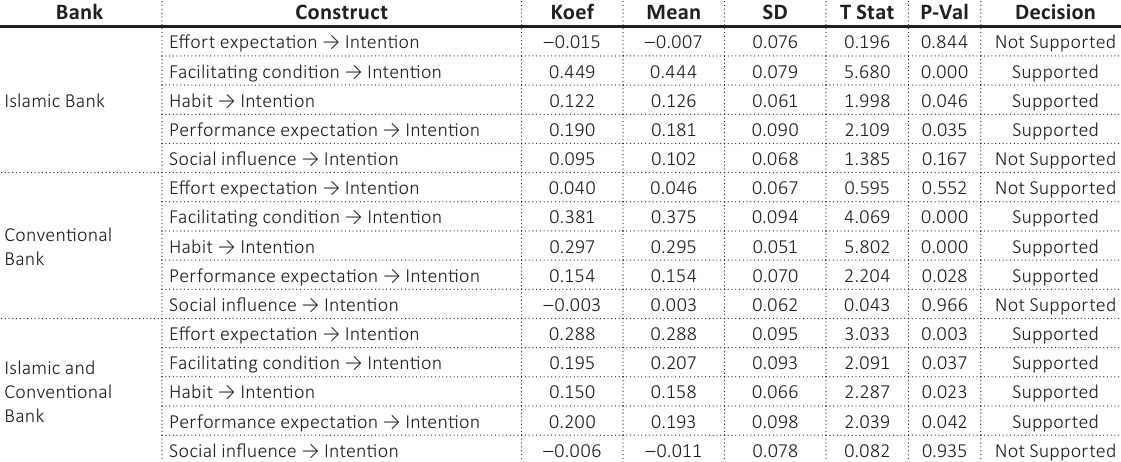
Table 5. Hypotheses